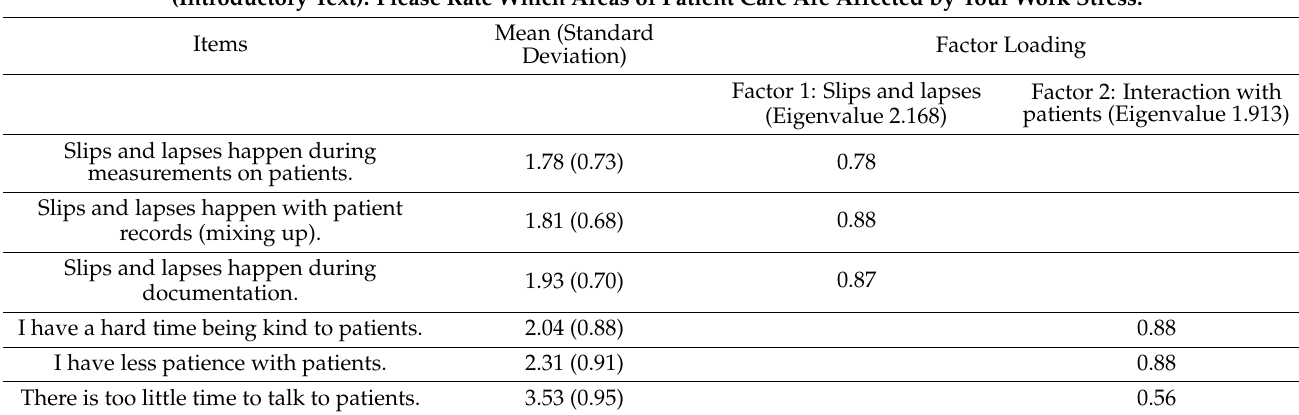
Factor 2: Interaction with patients (Eigenvalue 1.913)